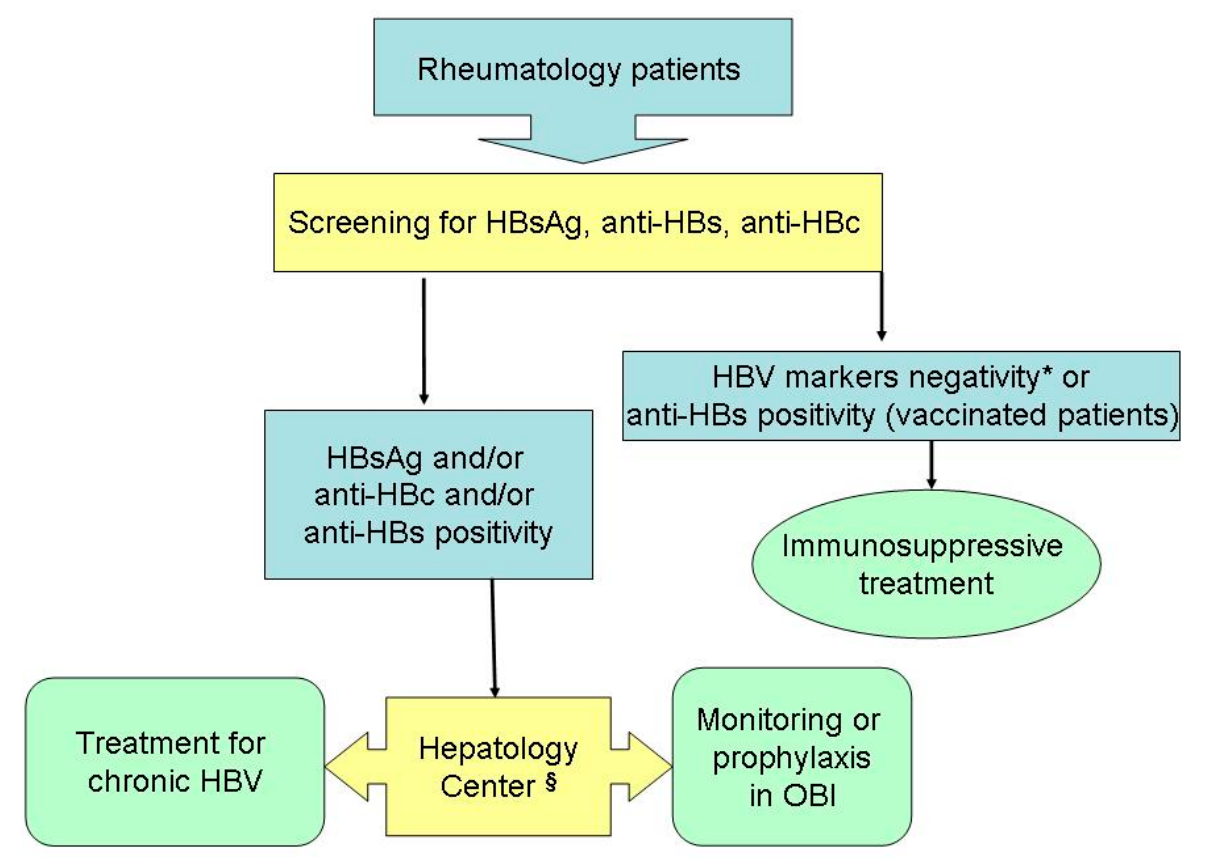
Figure 1. Proposed algorithm for rheumatic patients with OBI and HBV infection.